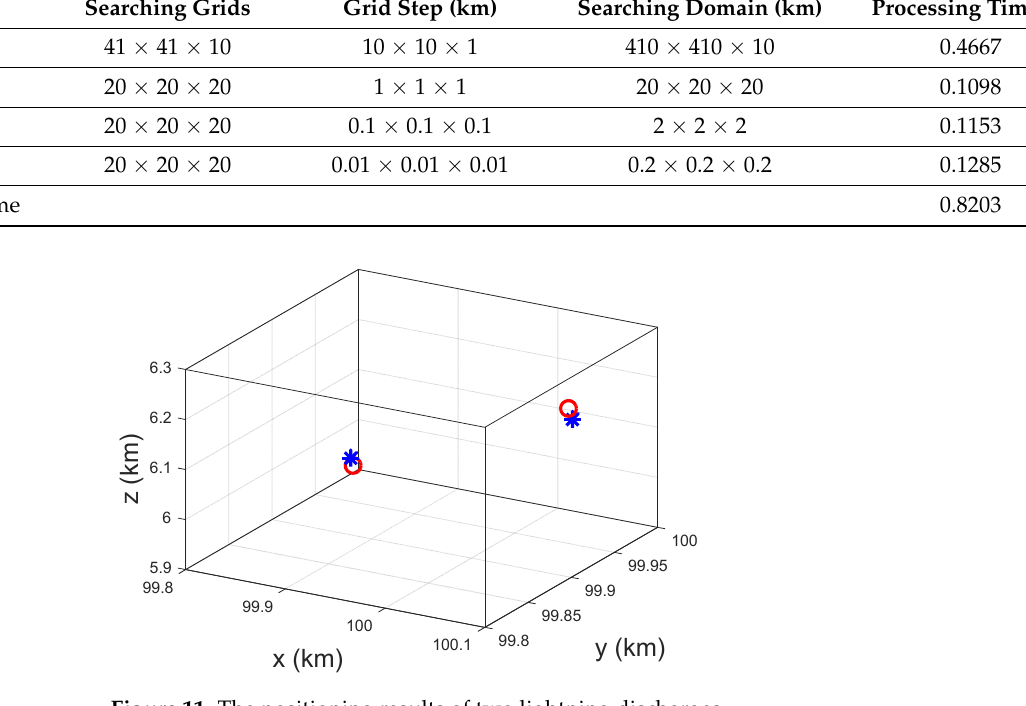
Figure 11. The positioning results of two lightning discharges .